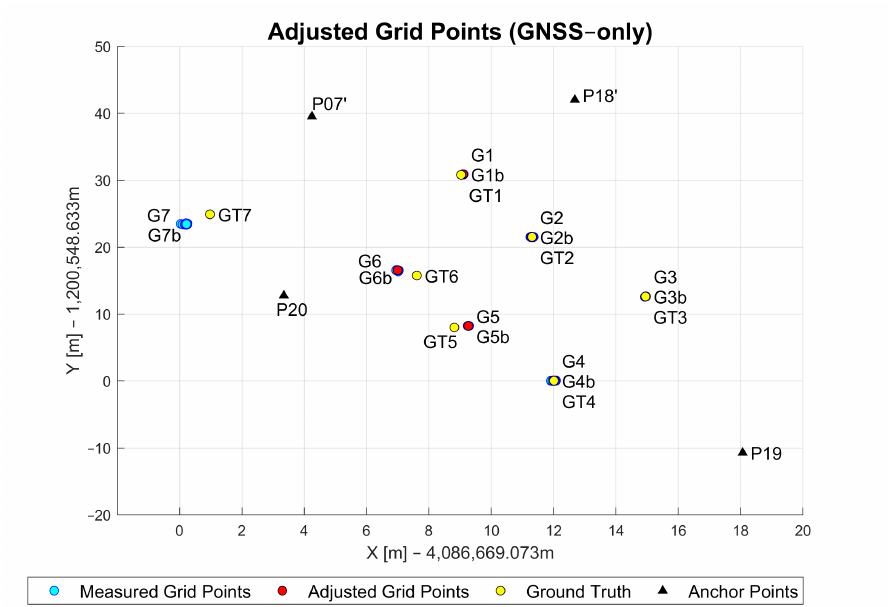
Figure 15. Adjusted, measured and ground truth grid point coordinates based on GNSS-only approach. Table 3. Measured GNSS grid point error statistics in (m). PNo. Avg.